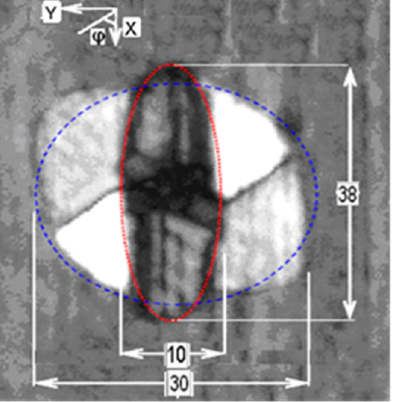
Figure 11. C-Scan image of the damage in a [(±45 C ) 2 ,(0 C ,0 G )4,(±45 C ) 2 ] face laminate specimens. Di- mensions are in mm and 0° plies are parallel to the x-axis of the image.